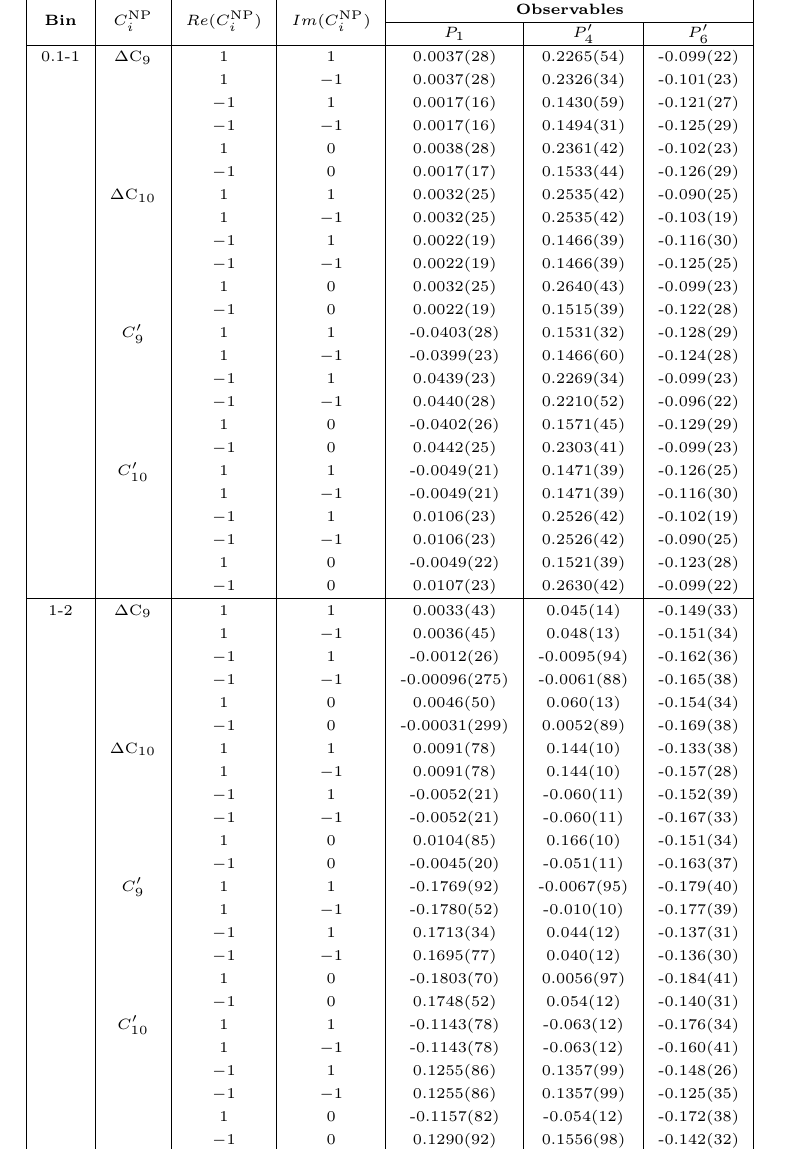
¯ B ( B ) → ρ 0 ll on the real and C 0 for the q 2 bins 0 . 1 − 1 and 1 − 2 GeV 2 for a 9 , 10 9 , 10